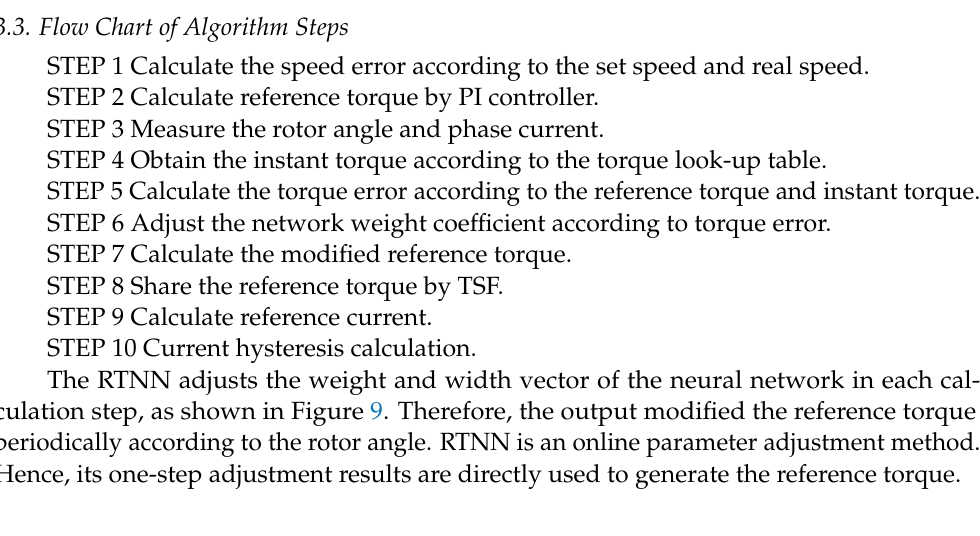
Figure 8. Relationship between total current and rotor